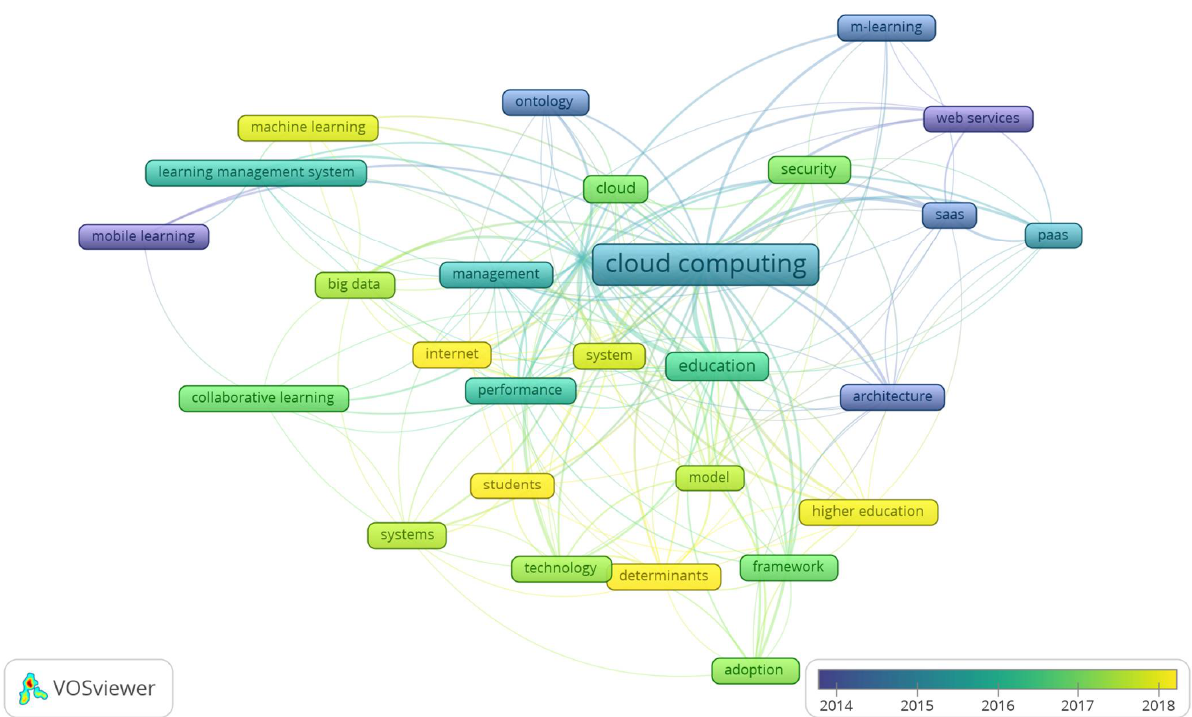
Figure 9. Network visualization map based on text data—Co-word analysis.